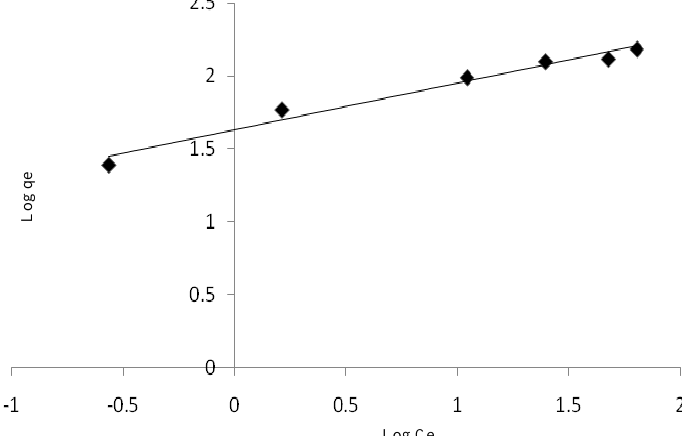
Figure 9. Freundlich isotherm for adsorption data of AR18 by MWCNTs; Time 120 min, dose: 0.04 g/100 mL,